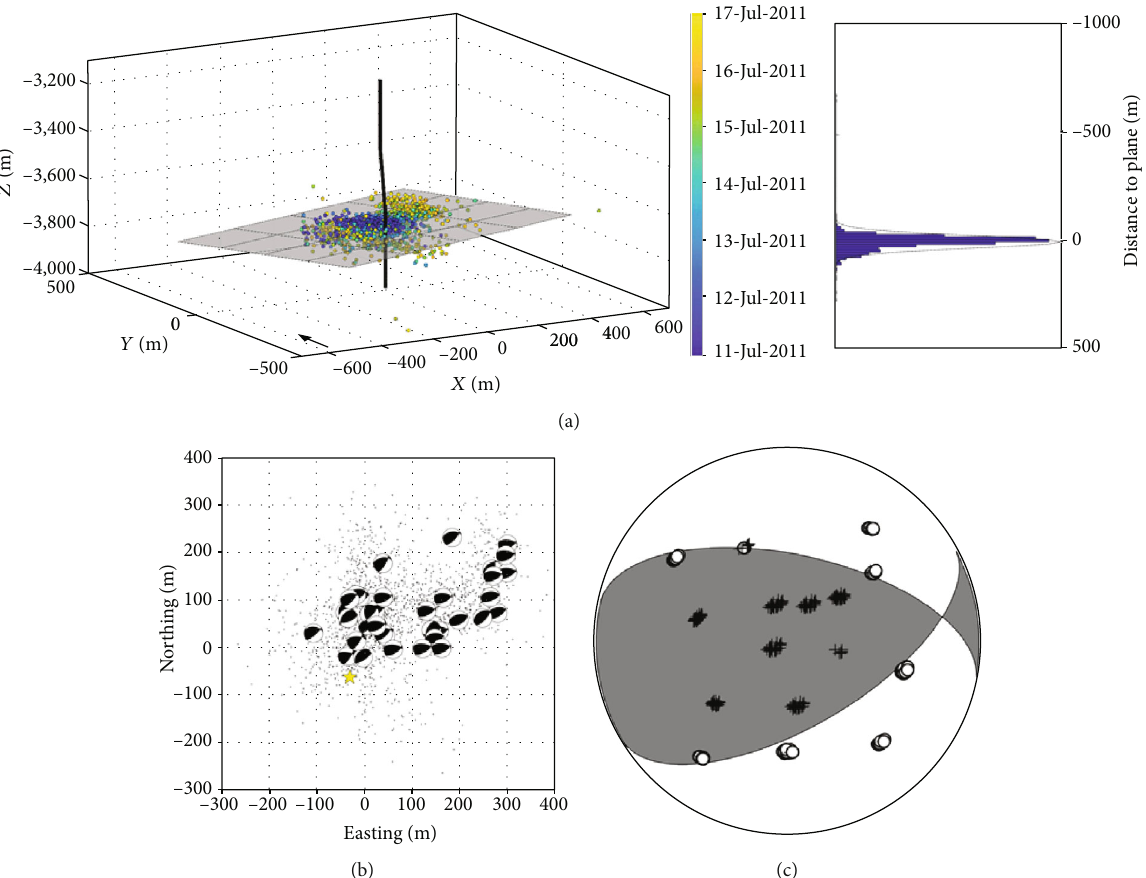
Figure 6: (a) Absolute hypocentre locations in perspective view with best- fi tting plane determined by linear regression. The histogram on the right shows vertical distances of the absolute hypocentre locations to the best- fi tting plane. Dotted curve indicates normal distribution with 0 mean and 30m standard deviation. (b) Map view of fault plane solutions determined for the 40 strongest events. Fracture intersection of the Paralana-2 injection well is indicated by a yellow star. (c) Earthquake source-centred, stereographic projection (lower hemisphere) of P -wave polarity data for the 40 strongest earthquakes. Beachball indicates compound fault plane solution. Coordinates are given with respect to the top of Paralana-2 (30.21287 ° S/139.72850 °